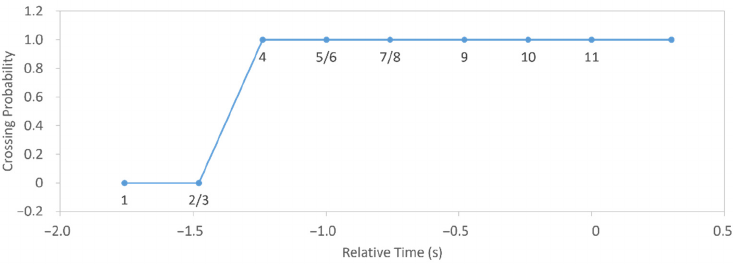
Figure 9. Pedestrian behavior key-point identification.